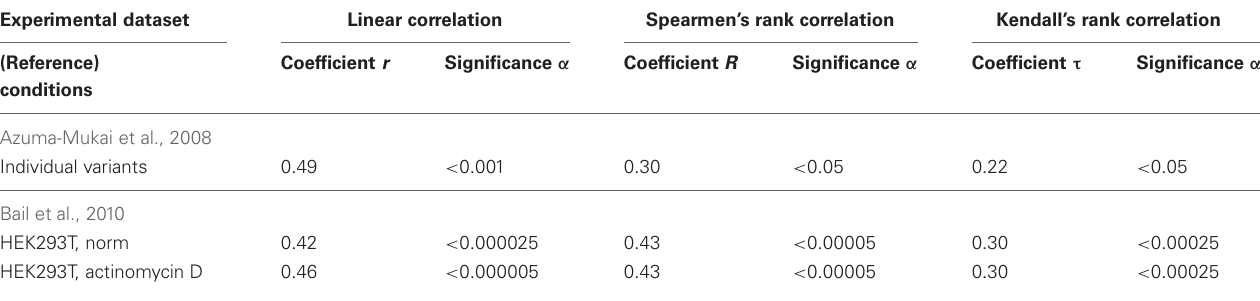
Table 4 | Nine correlations in human (Figures 7, 8) between the miRNA abundance estimated by Equation (5) and those measured